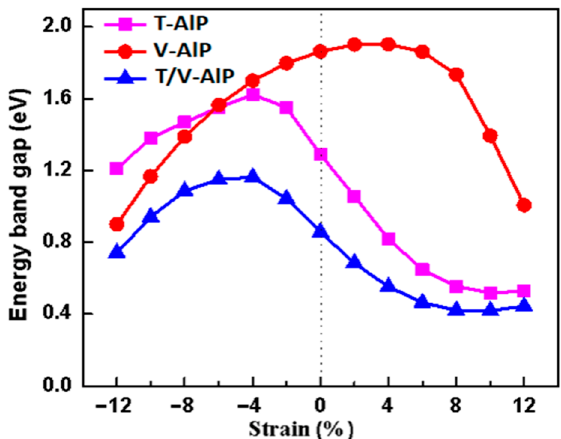
Figure 5. The band gaps of the T-AlP, V-AlP and T/V-AlP bilayers versus biaxial strain. The vertical dotted line corresponds to the unstressed condition. The biaxial strain step is 2% in our work.